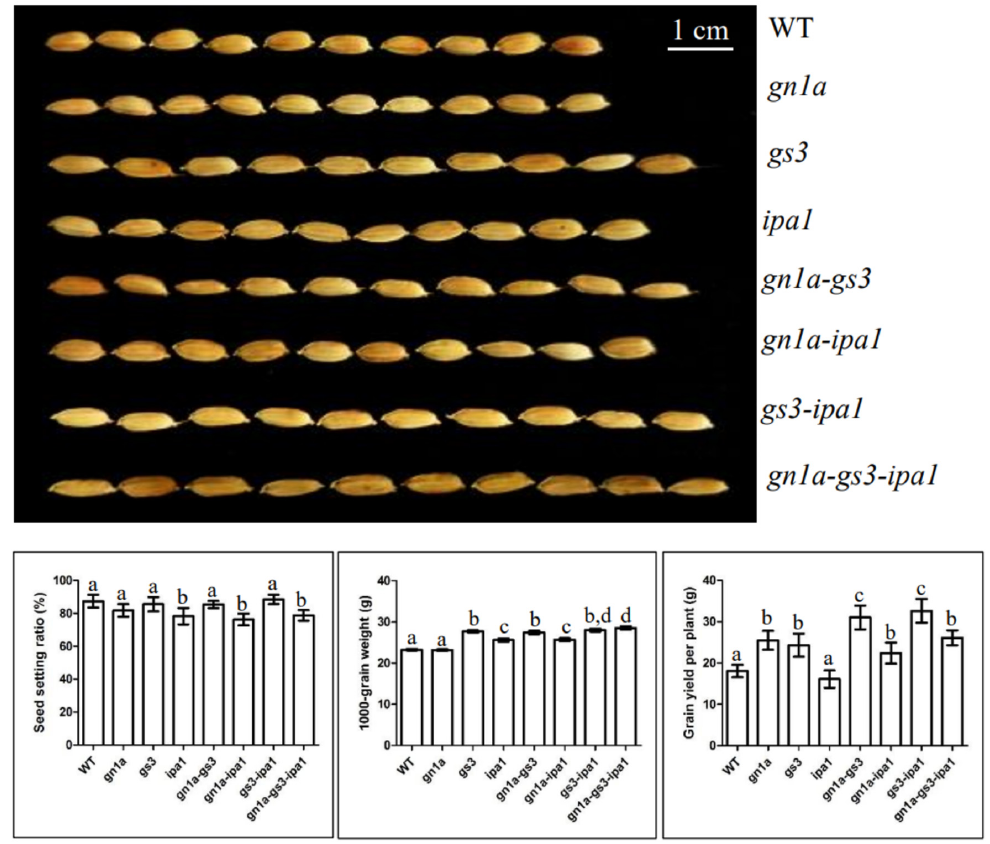
Figure 2. Representative grain size, seed setting rate, 1000-weight, and grain yield per plant of the T3 generation. Seed length was compared by line up of 10 seeds. Means labeled with different lower letters are significantly different by the Duncan Multiple Range Test at p < 0.05.